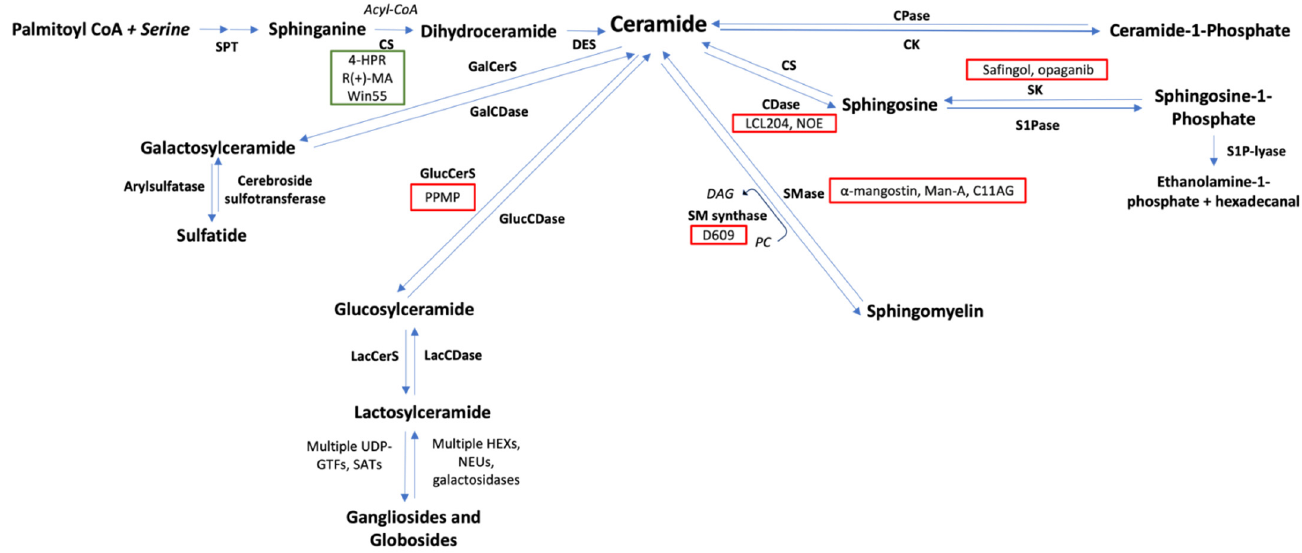
Figure 3. Potential therapeutical with published evidence against lymphomas. Green boxes repre- sent enzymatic inducers and red boxers represent enzymatic inhibitors. SPT: serine palmitoyltransferase; CS: ceramide synthase; DES: dihydroceramide desaturase; CDase: ceramidase; SK: sphingosine kinase; S1Pase: sphingosine-1-phosphate-phosphatase; S1P-lyase: sphingosine-1-phosphate lyase; S1PR1: sphingosine-1-phosphate receptor 1; CK: ceramide kinase; CPase: ceramide-1-phosphate-phosphatase; SMS: sphingomyelin synthase; SMase: sphingomyelinase; PC: phosphocholine; DAG: diacylglycerol; GluCerS: glucosylceramide synthase; LacCerS: lactosylceramide synthase; HEXs: hexosaminidases; NEUs: neuraminidases; GTFs: glycosyltransferases; SATs: sialyltransferases; GlucCDase: glucosylceramidase; GalCerS: galactosylceramide synthase; GalCDase: galactosylceramidase; 4-HPRT: N-(4-hydroxypheny) retinamide (fenretinide); R(+)-MA: R(+)-methanandamide; PPMP: 1-phenyl-2-palmitoylamino-3-morpholino-1-propanol; D609: Tricyclodecan-9-yl- xanthogenate; NOE: N-oleoylethanolamine; Man-A: Manomycin A; C11AG: undecylidene-amino- guanidine.